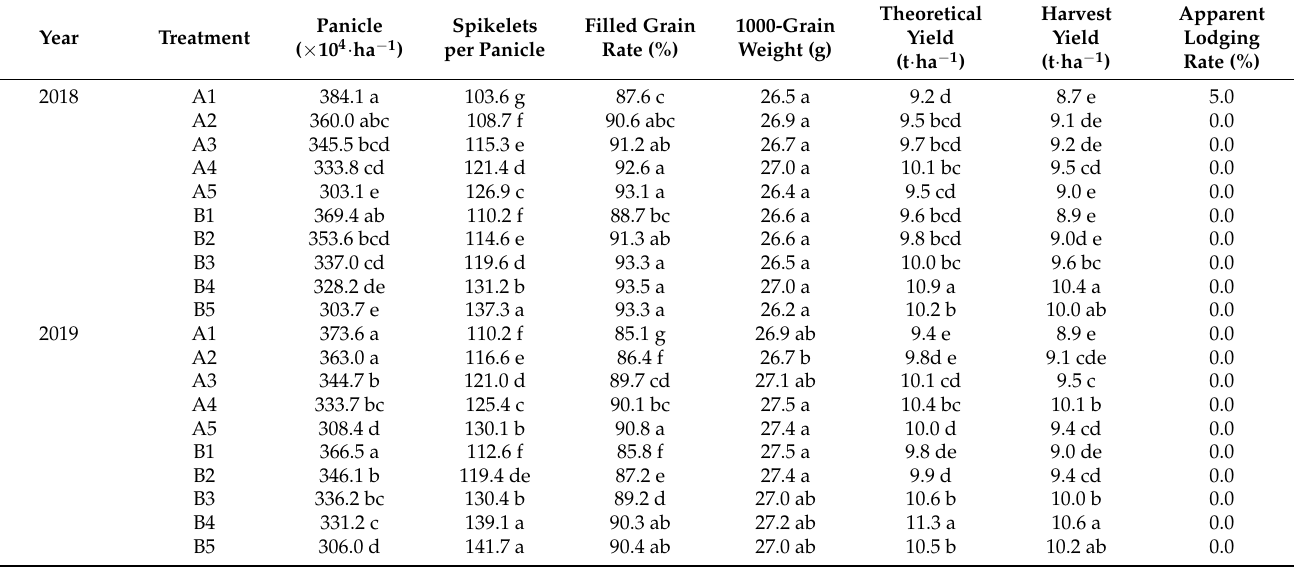
Table 2. Rice yield and its components as affected by mechanical transplanting method and planting